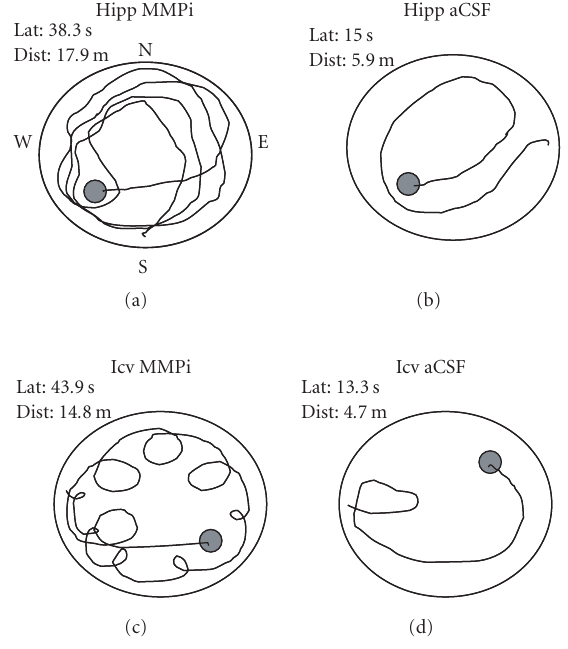
Figure 2: Representative examples of search patterns in the Mor- ris water maze during a 120-second trial on day 8 of acquisition training by one member of each group. Latency (Lat) and distance (Dist) to find the platform are provided for each rat. Bilateral in- jection of MMPi into dorsal hippocampi (Hipp) or icv resulted in impaired search patterns characterized by frequent swimming near the walls of the maze (positive thigmotaxis). Those animals injected with aCSF into dorsal hippocampi or icv displayed superior search patterns culminating in short latencies and distances to find the platform. Members of these groups did not di ff er with respect to swim speeds which ranged from 0.30 to 0.32 m/s.